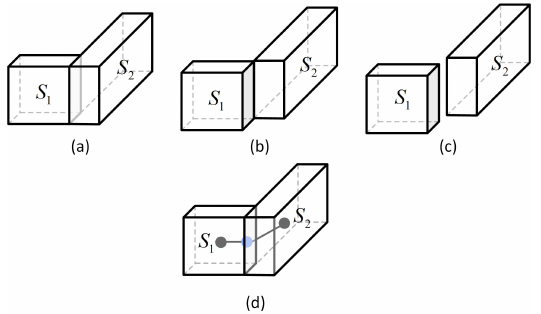
Figure 1. Illustration of connected spaces. Only the two spaces in (a) are regarded as connected spaces while that in (b) and (c) are unconnected. The (d) shows the navigation network between the two spaces, in which the blue dot is the additional vertex on the face two spaces touch to indicate how to traverse the